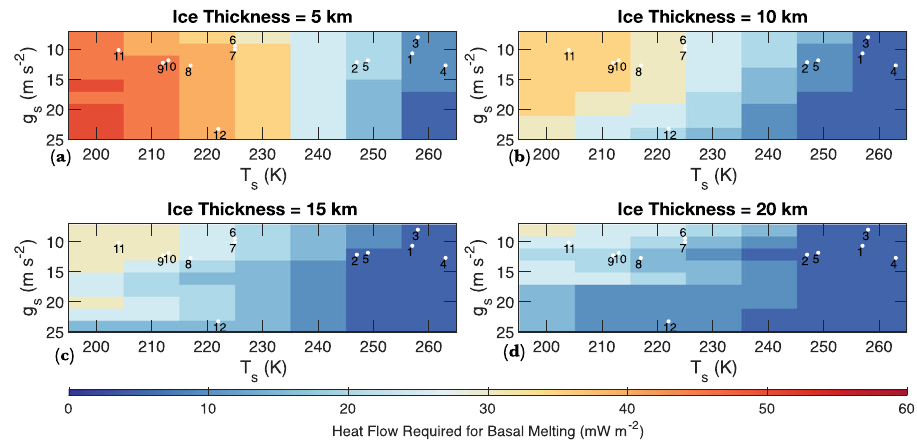
Fig.6|Heat fl owrequiredforbasalmeltingasafunctionofsurfacegravityand temperature for ice sheets 5 – 20km in thickness. a Heat fl ow required for basal meltingasafunctionofsurfacegravityandsurfacetemperaturefora5-kmthickice